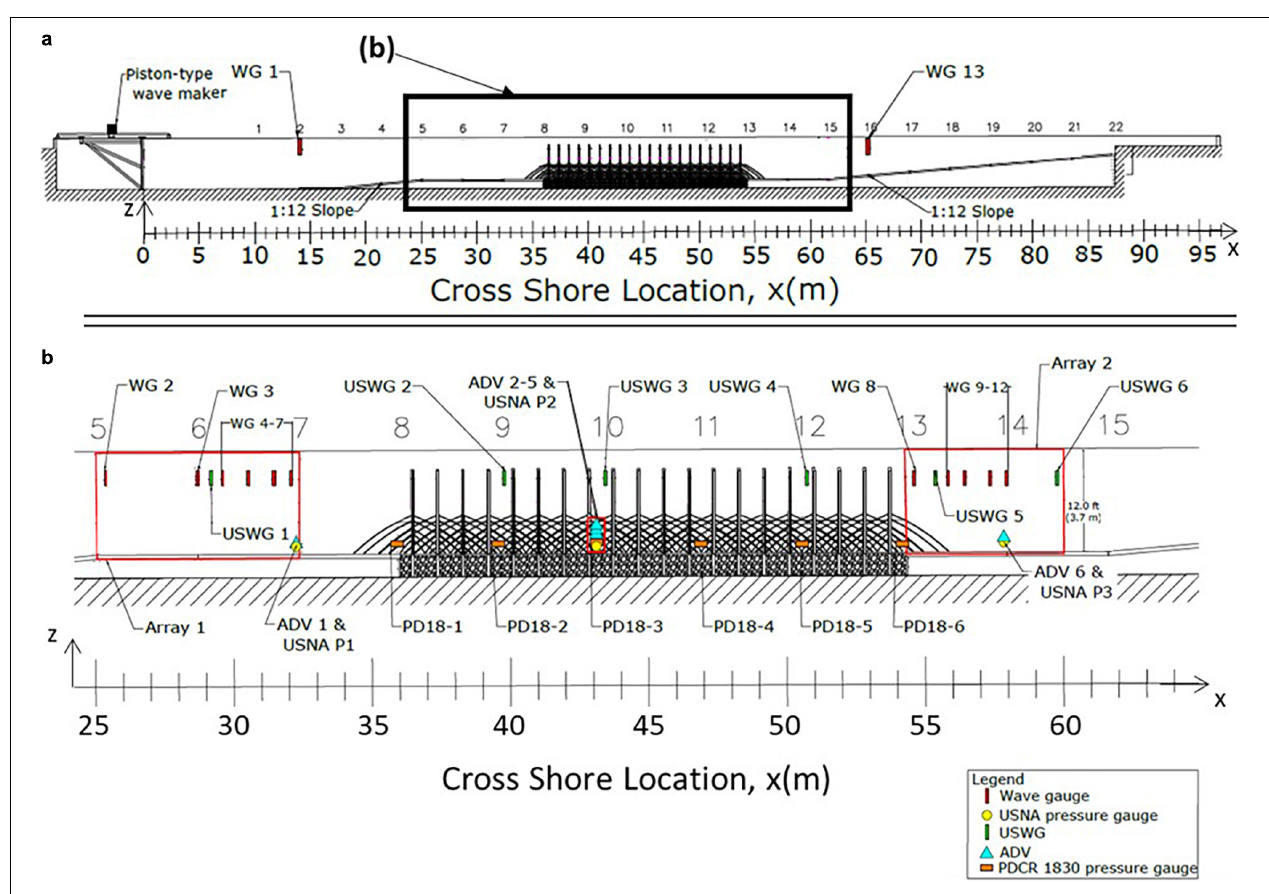
FIGURE 2 | (a) Profile view of flume showing bathymetry, location of mangrove forest, and numbered bays 1–22. (b) Detail profile view of horizontal test section between bays 5–15 showing instrumentation locations in test